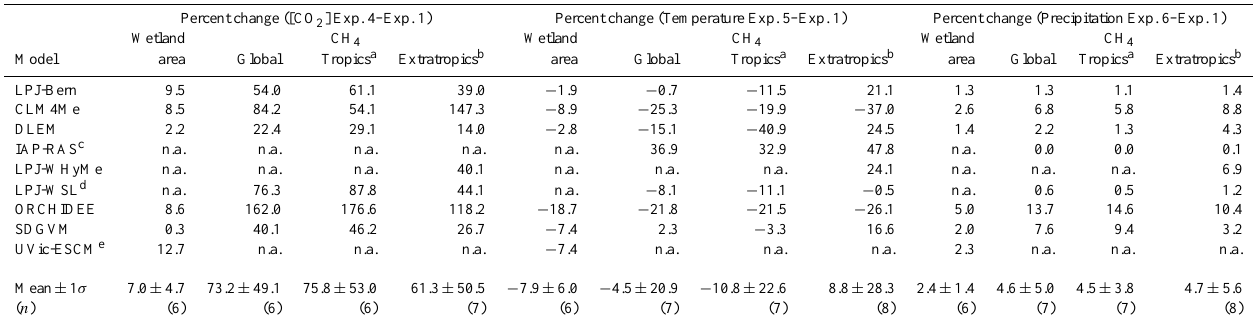
a The tropics are defined here as 30 ◦ S to 30 ◦ N. b Extratropical region low latitude limit ( > 35 ◦ N) chosen to coincide with the low latitude limit of peatland distribution in Tarnocai et al. (2009) used by the LPJ-WHyMe model. c IAP-RAS is not sensitive to [ CO 2 ], so we did not perform this experiment (see Eliseev et al., 2008; Wania et al., 2012). Additionally, IAP-RAS has fixed wetland extents.